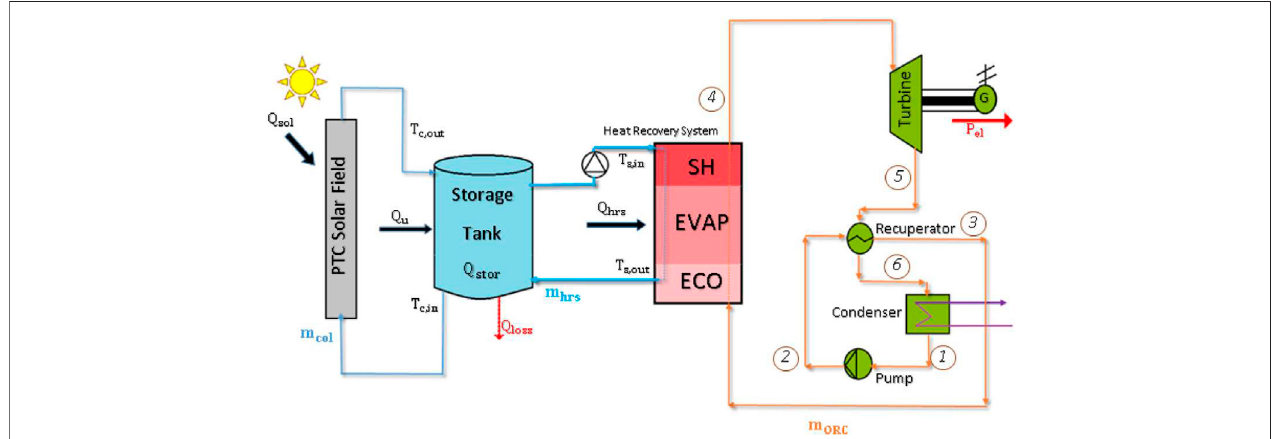
FIGURE 3 | Schematic of regenerative solar ORC with different types of storage units (Bellos et al., 2020).